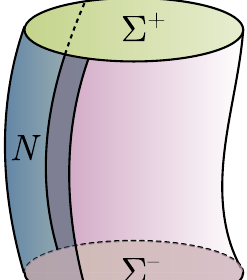
Figure 4. A manifold M with boundary @M = (cid:6) + [ (cid:6) (cid:0) [ (cid:0), and timelike region N (cid:26) (cid:0) coupling to bulk